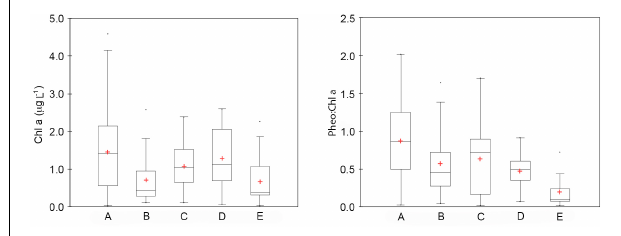
FIGURE 5 | Boxplots of chl a (mg L − 1 ) and phaeo:chl a ratio for each sub-system: Area 1 (A) , Area 2 (B) , Area 3a (C) , Area 3b (D) , Area 4 (E) . The black line is the median and the red cross is the mean.